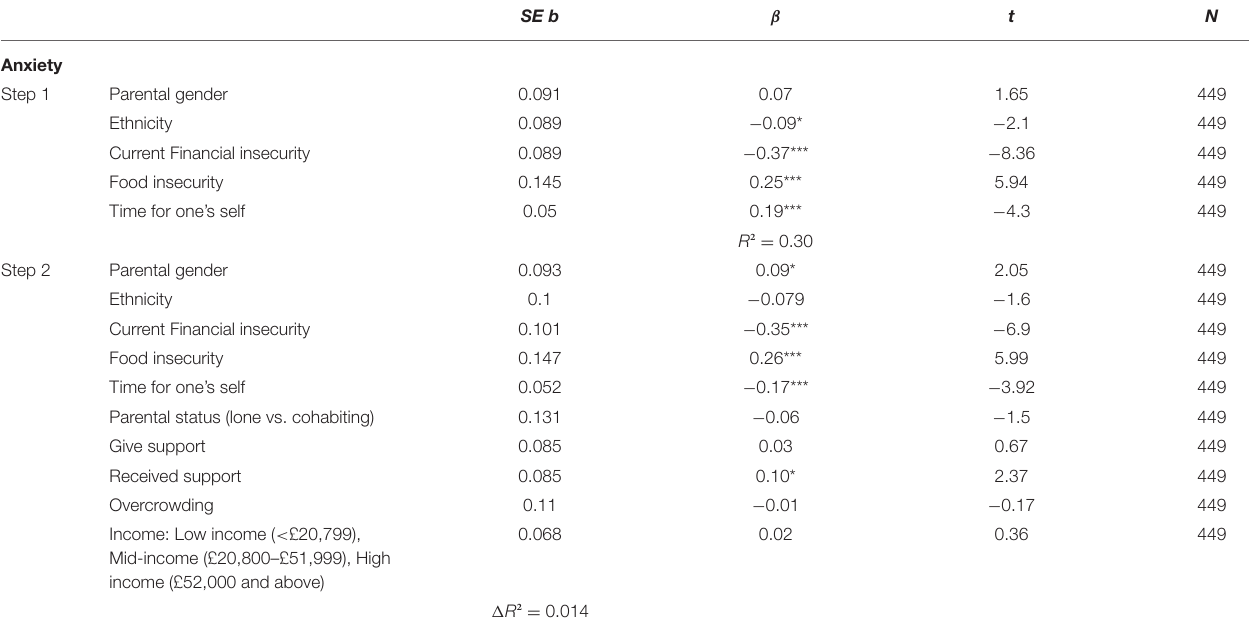
TABLE 4 | Hierarchical regression analyses predicting symptoms of